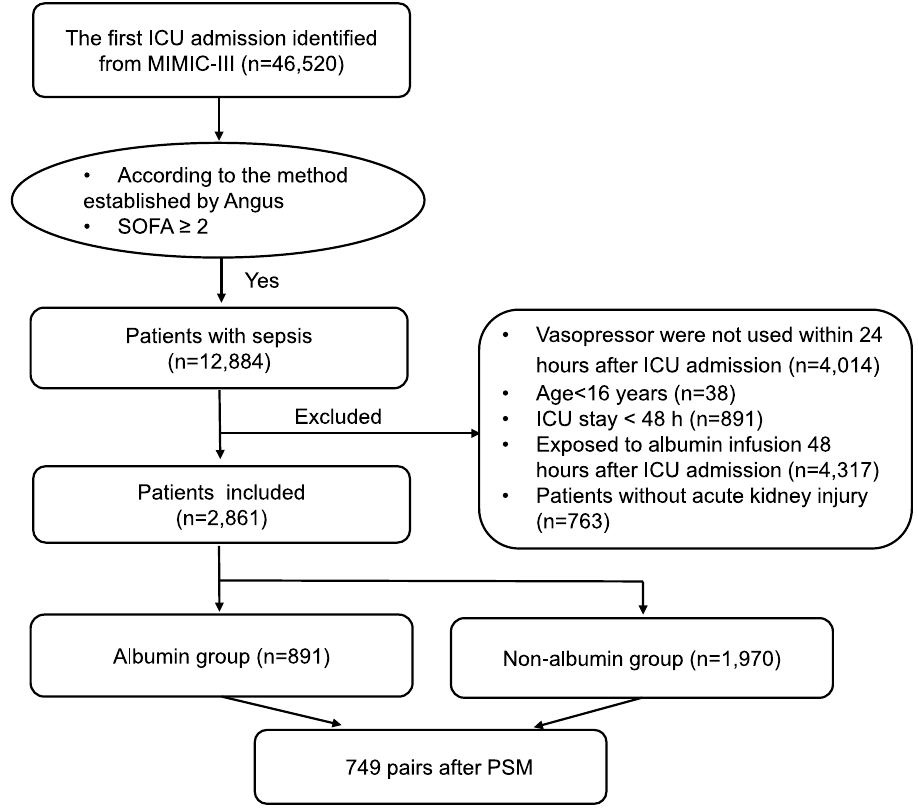
Figure 1. Flowchart of patient inclusion. MIMIC-III Multiparameter Intelligent Monitoring in Intensive Care Database III; SOFA sequential organ failure assessment; ICU intensive care unit; PSM propensity-score